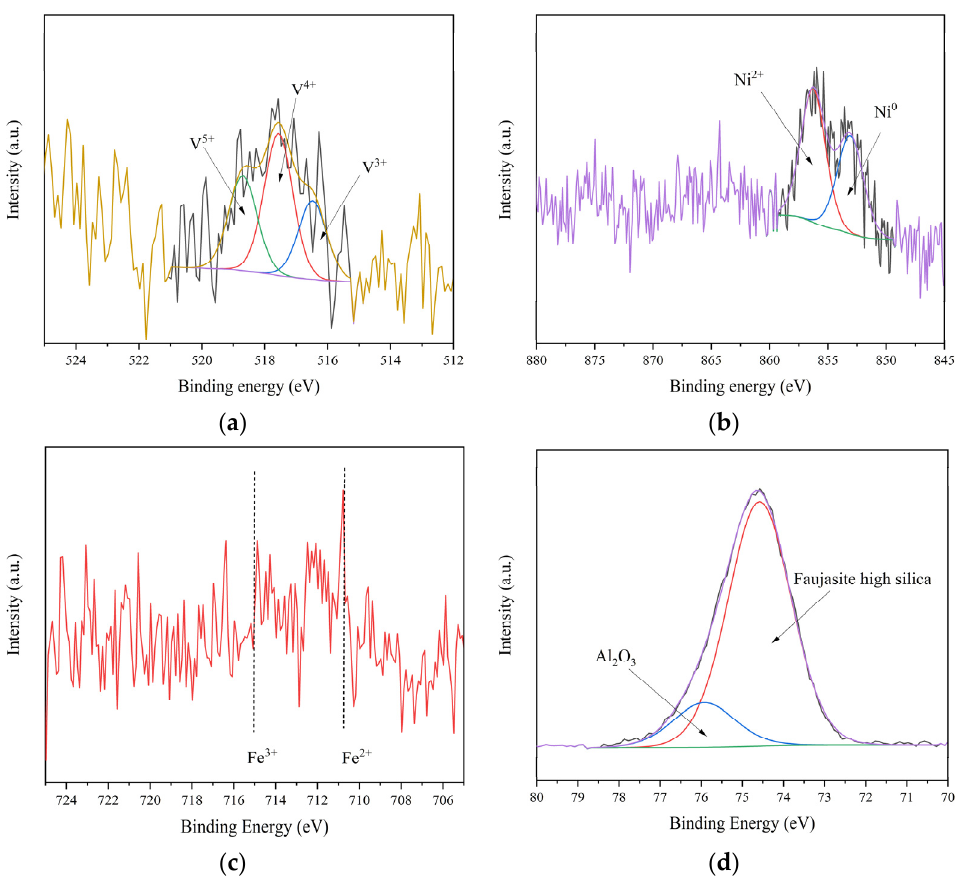
Figure 3. XPS spectra of SFCC catalysts: ( a ) V2p, ( b ) Ni2p, ( c ) Fe, and ( d ) Al.